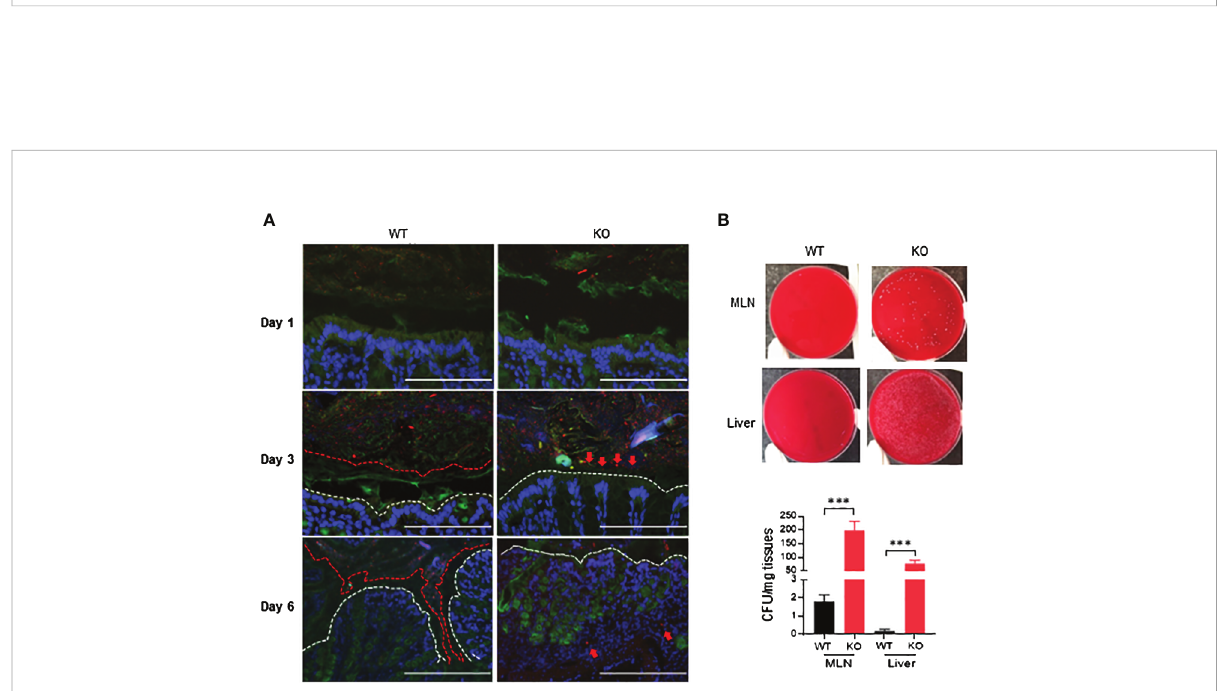
FIGURE 5 Luminal bacterial invasion in colon and dissemination into mesenteric lymph nodes and live of AKR1B8 KO mice under acute colitis. (A) Bacterial invasion in the colon. Bacteria were stained by fl uorescent in-situ hybridization using the general bacterial rRNA probe, EUB338 conjugated with Alxea 555 (red). The mucus was visualized by immunostaining of the same section with an anti-Muc2 speci fi c antibody (green). White dotted line indicates the colonic epithelium. Arrows point out the penetration of bacteria into inner layer of mucus (day 3) and colonic lamina propria (day 6) in AKR1B8 KO mice in DSS treatment. Scale bars, 200 m m. (B) Bacterial dissemination into MLN and liver. Suspension (supernatant) from mesenteric lymph nodes (MLN) and liver was subjected to bacterial cultures in blood agar plates on day 6 ( upper panel ), and the numbers of bacterial cfu were counted ( lower panel ). KO, knockout; WT, wild type. ***p < 0.001.